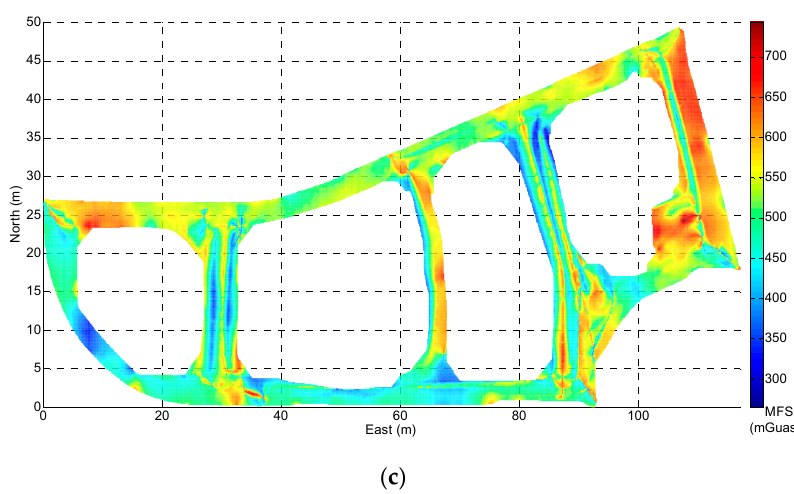
Figure 8. The magnetic field strength map. ( a ) Building A; ( b ) building B; ( c ) building C.